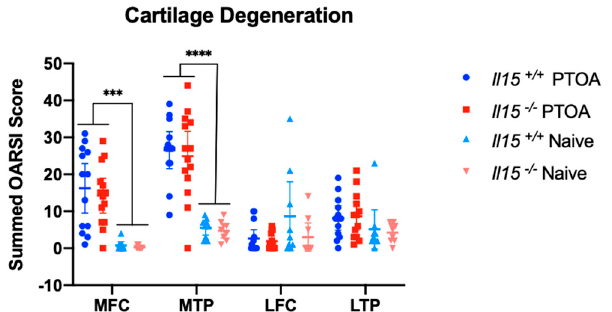
Figure 5. Cartilage damage is not significantly different between Il15 +/+ PTOA and Il15 − / − PTOA rats. Animals either underwent ACLT-DMM surgery to induce PTOA or served as control with no surgery (Naive). Semi-quantitative scoring (scale 0–5) of toluidine blue-stained paraffin sections was used to determine the extent of cartilage damage in the joint via 4 compartments; medial femoral condyle (MFC), medial tibial plateau (MTP), lateral femoral condyle (LFC), and lateral tibial plateau (LTP). Two-way ANOVA with Tukey’s multiple comparison test was used for statistical analysis; data represents mean with 95% CI. There was no significant difference in the summed scores between the Il15 +/+ PTOA and Il15 − / − PTOA groups. The PTOA groups scored significantly higher than the Naive groups in the medial compartment. (*** p < 0.001, **** p < 0.0001, N = 15 rats/PTOA group and 9 rats/Naive group).